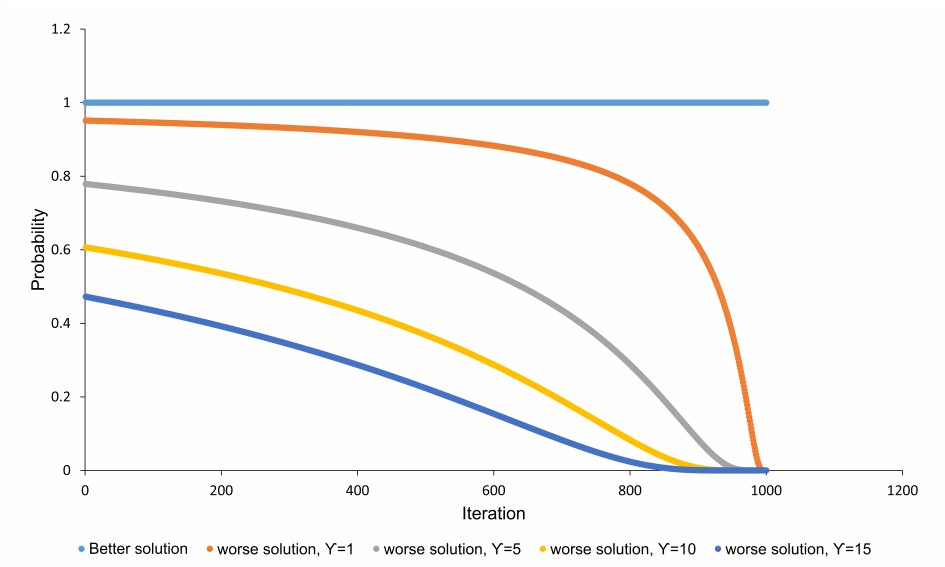
Figure 9. Probability of selecting a better or a worse solution (50 s worse), using different γ values, depending on the progress of a run of 1000